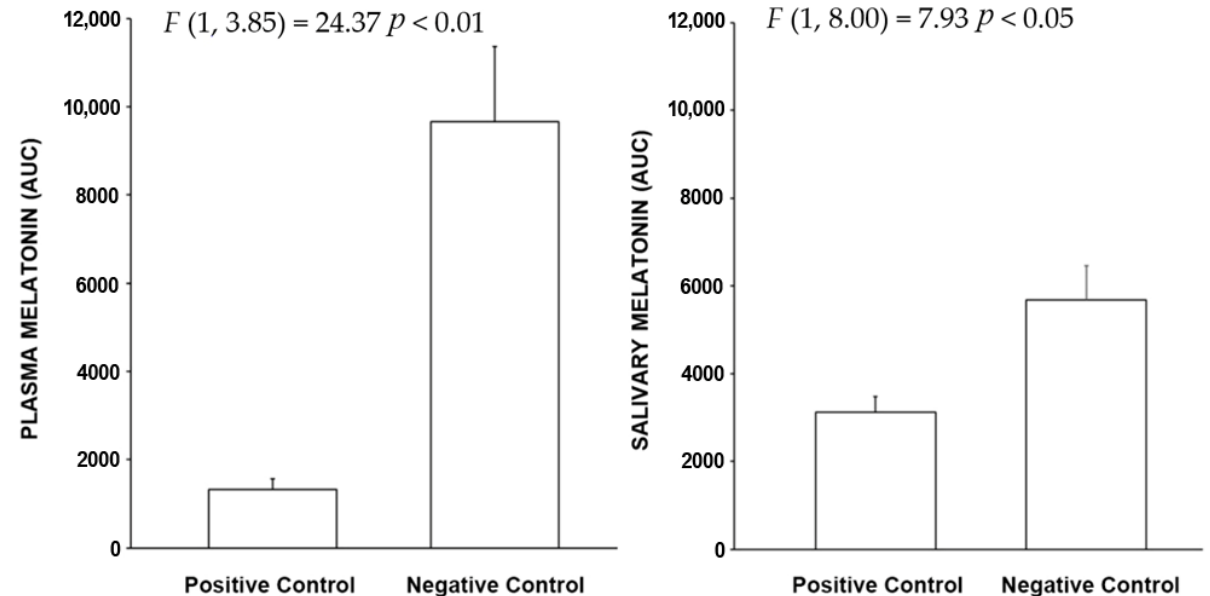
Figure 4. The bars shown above represent the mean (+ SEM) AUC plasma and salivary melatonin levels for the positive and negative control conditions. The integrated melatonin AUC values were calculated from the raw plasma and salivary melatonin values shown in Figure 3 for the exposure period only (10:00 P.M. to 2:00 A.M.) The statistics are based on the LMM.